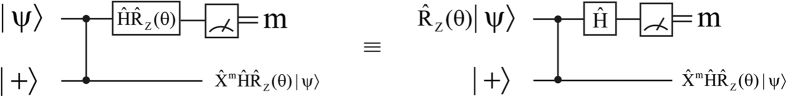
Generalised one-bit teleportation circuit.LHS of the equivalence sign: measuring the first qubit with the θ angle in the (X, Y) plane, and RHS of the equivalence sign: applying a Z-rotation on the first qubit and measuring it in the X-basis. The two circuits are equivalent.